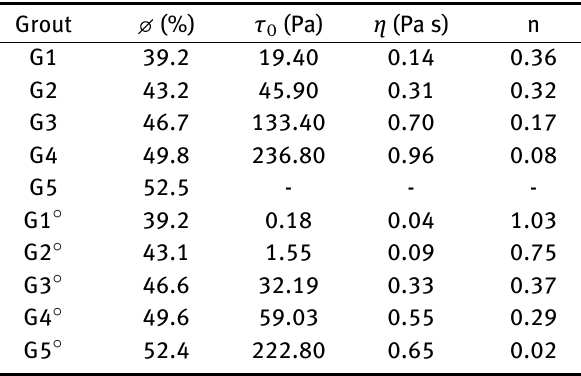
Table 6: Parameter values of the Herschel-Bulkley model.